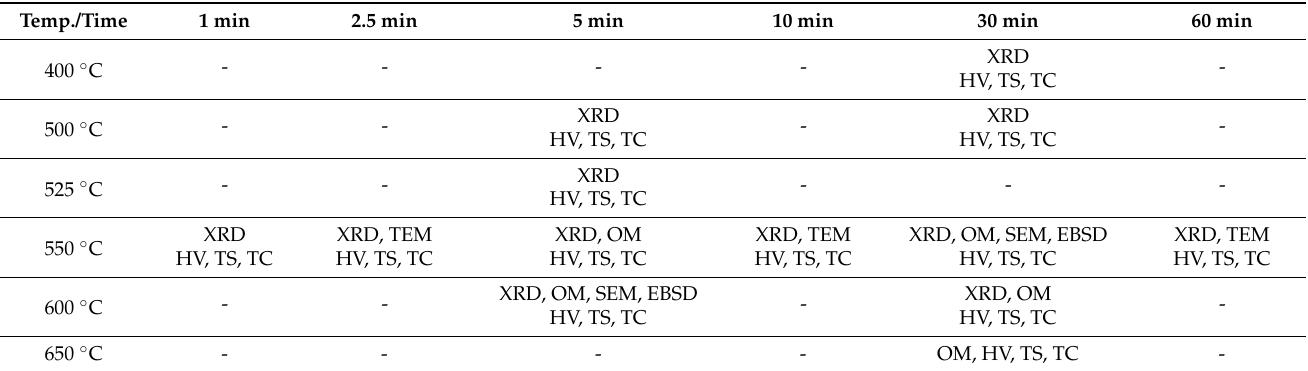
Table 1. Microstructure analysis and mechanical characterization techniques applied to the ECAP- PDA Ti-Zr-Nb alloy